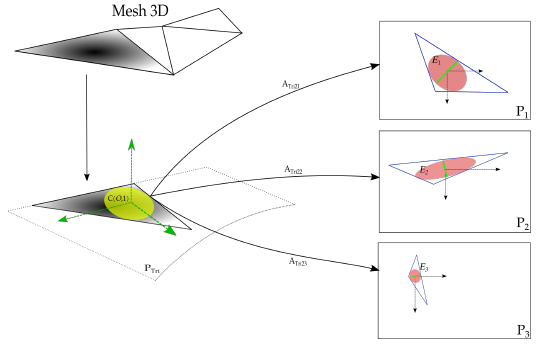
Figure 2. Master image selection by optimal resolution condition.